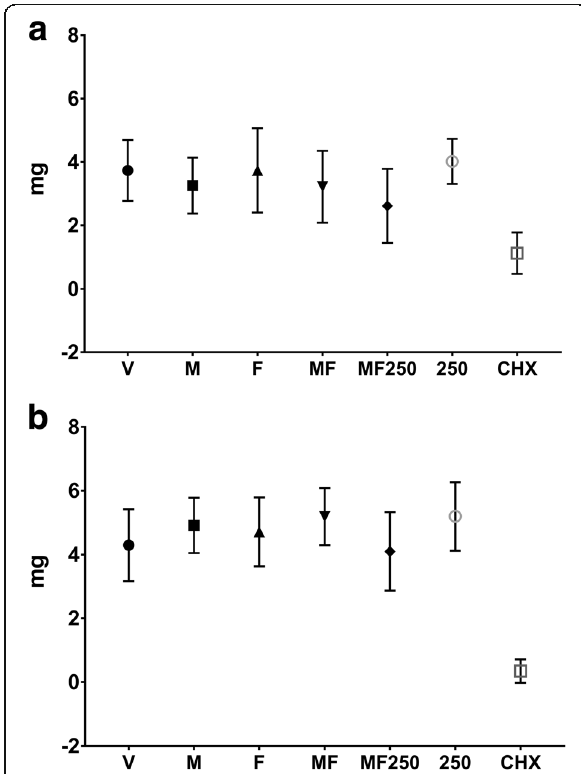
Fig. 3 Biomass of treated biofilms. a represents the data generated for regimen one, while ( b ) for regimen two. V: vehicle; F: tt- farnesol; M: myricetin; MF: tt -farnesol + myricetin; MF250: fluoride + tt- farnesol + myricetin; 250: fluoride (250 ppm); CHX: chlorhexidine. The data shown are averages, and error bars indicate the standard